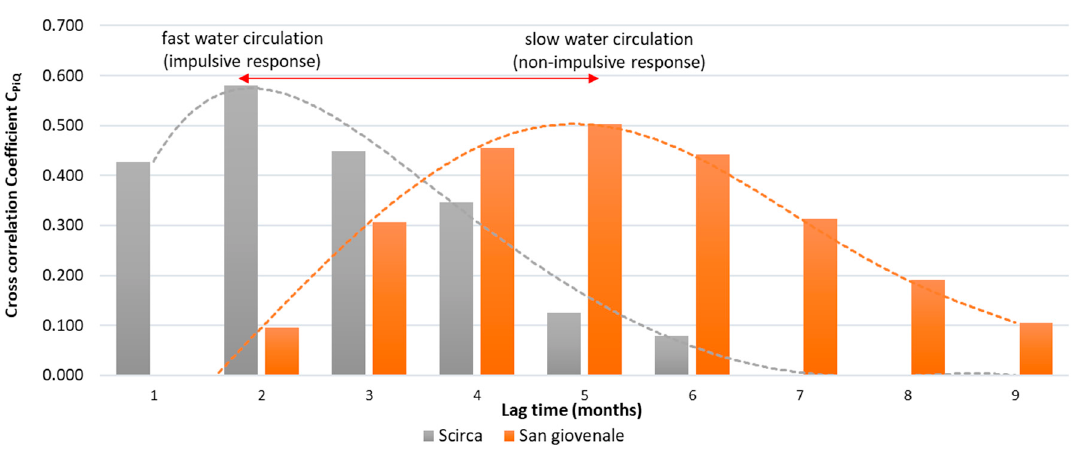
Figure 5. C PiQ values obtained for two test springs in Italy (Scirca Spring and San Giovenale Spring).